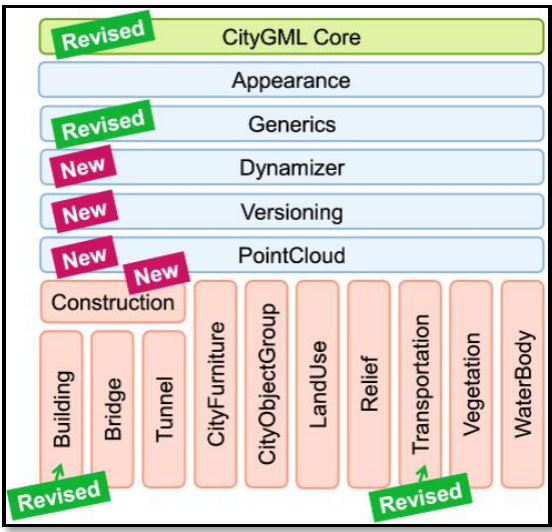
Figure 2. CityGML 3.0 module Overview (Kutzner et al., 2020)